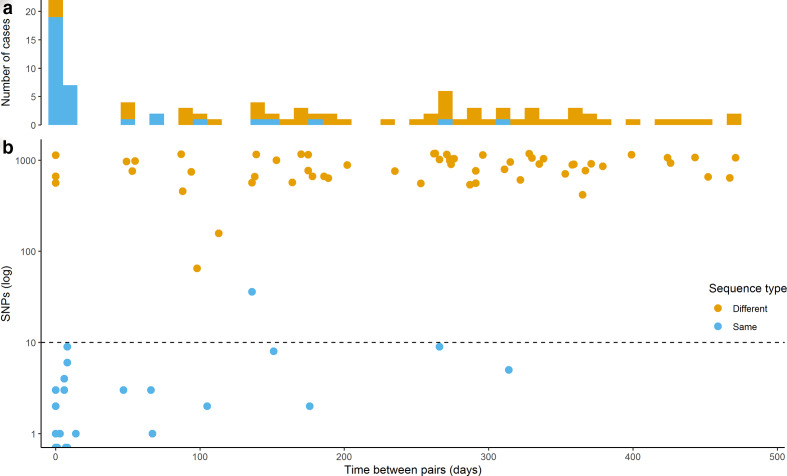
On the same x-axis showing time between pairs of isolates (in days): (a) the number of cases with either different or same ST, and (b) the pairwise SNP differences (log scale) between isolates.